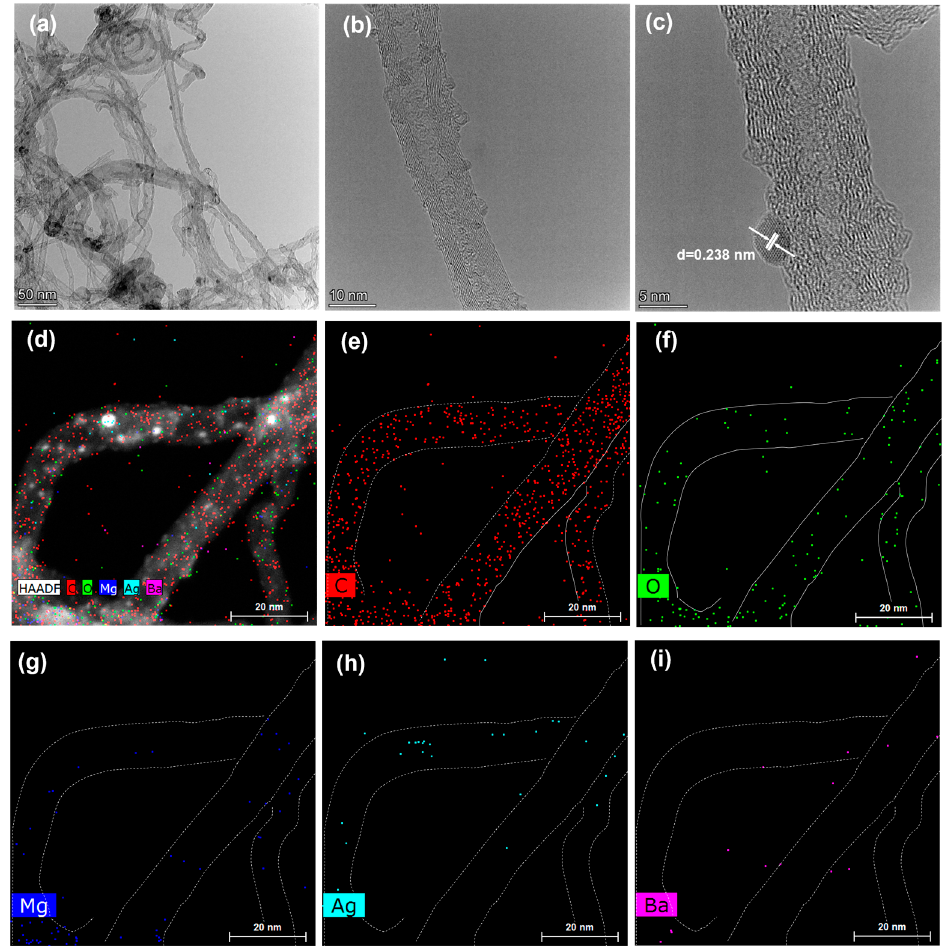
Figure 3. TEM images and EDS analysis of the CNT-MgO-Ag-BaO composite. ( a ) Low-resolution TEM image of the CNT-MgO-Ag-BaO sample, and HRTEM images of ( b ) CNT and ( c ) Ag nanoparticle; ( d – i ) EDS mappings of C, O, Mg, Ag, and Ba elements from the CNT-MgO-Ag-BaO composite.